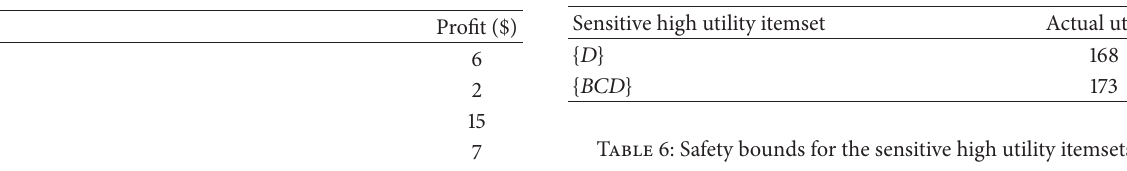
Table 3: A proit table. Table 5: Actual utilities for the sensitive high utility itemsets.